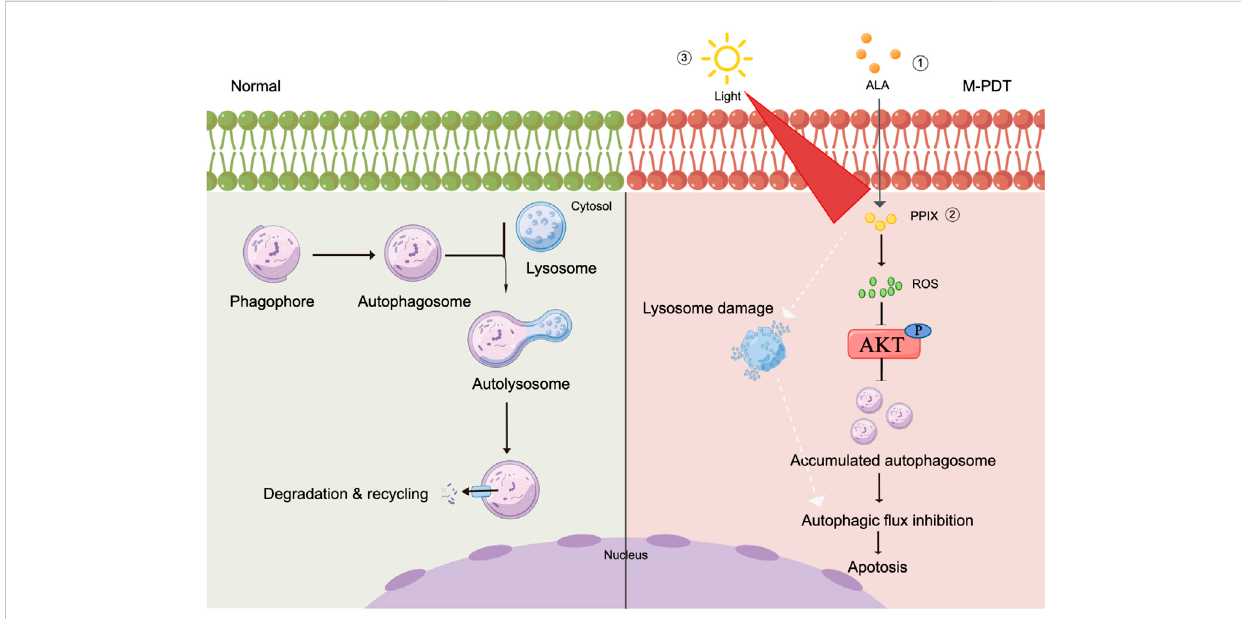
FIGURE 8 Graphical model demonstrates that M-PDT hinders autophagic fl ux contributing to cSCC cell viability suppression. M-PDT inhibits ROS-mediated Akt, thereby hinders autophagic fl ux. Consequently, the accumulated autophagosomes induce cSCC cell viability inhibition. In addition, M-PDT could induce lysosomal dysfunction in a ROS-independent manner. The fi gure is created by